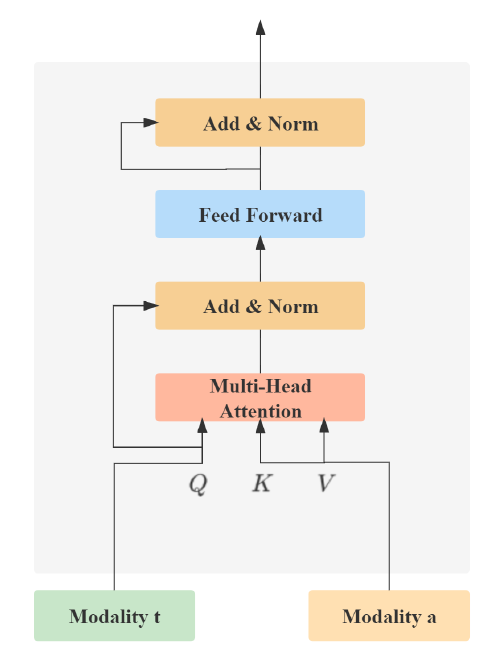
Figure 4. The architecture of the cross-attention